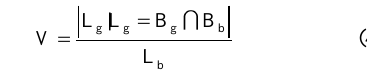
The probability distribution map of water body can be gained by the superposition analysis of the water body distribution of 40 views of TM images. The probability distribution is shown in Figure 3. The water in different regions has clearly different probabilities. The probability of water distribution significantly changed in the edge area. This result indicates that the water body in the edge water area has a lower water level and tends to evolve into other land types in a short period of time.